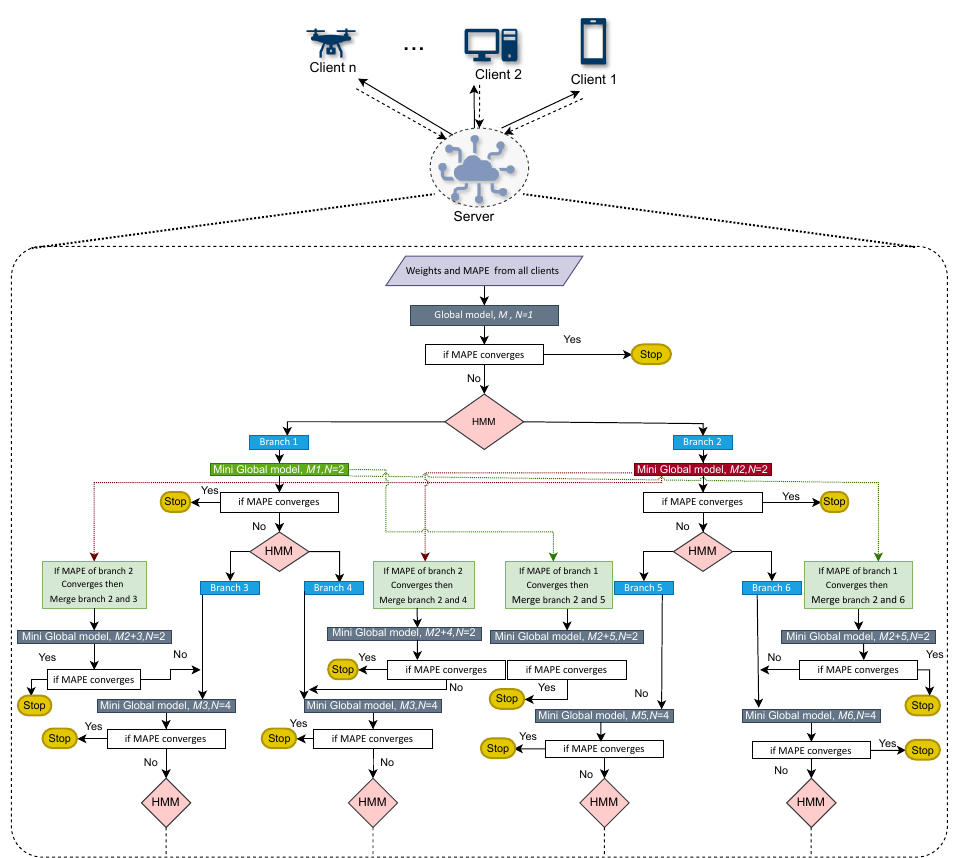
Figure 1. Framework of